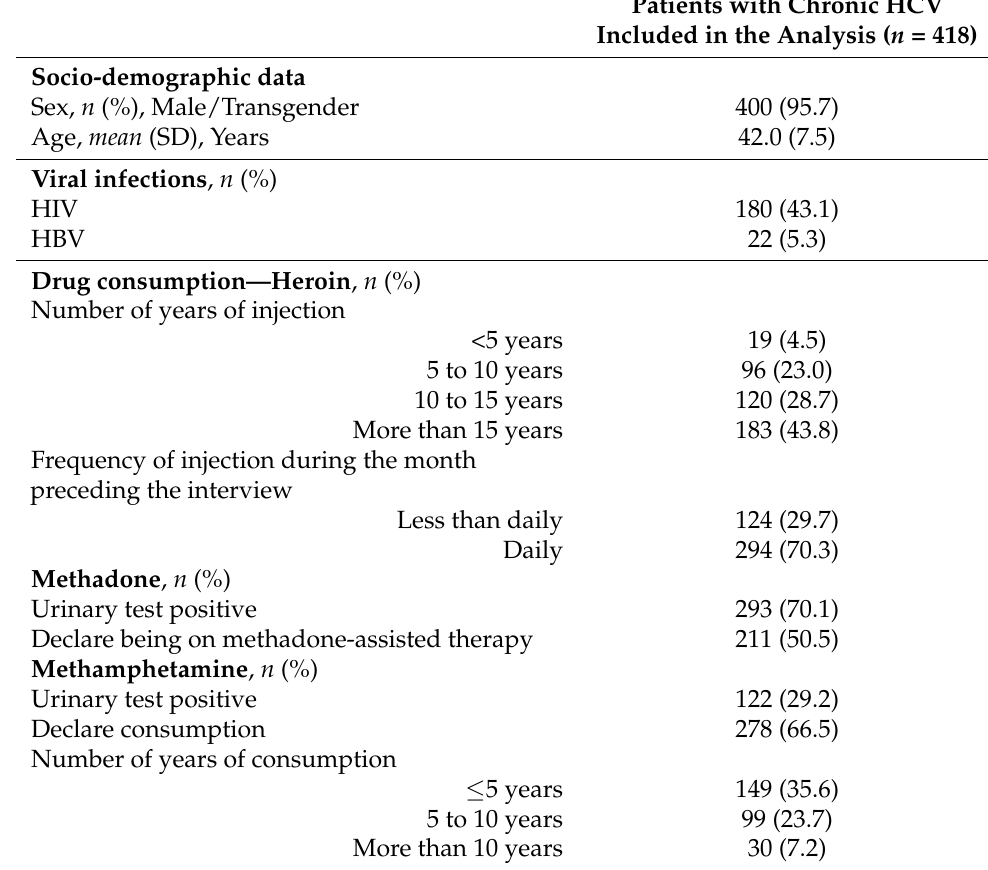
Table 1. Baseline characteristics of HCV-positive PWID in Hai